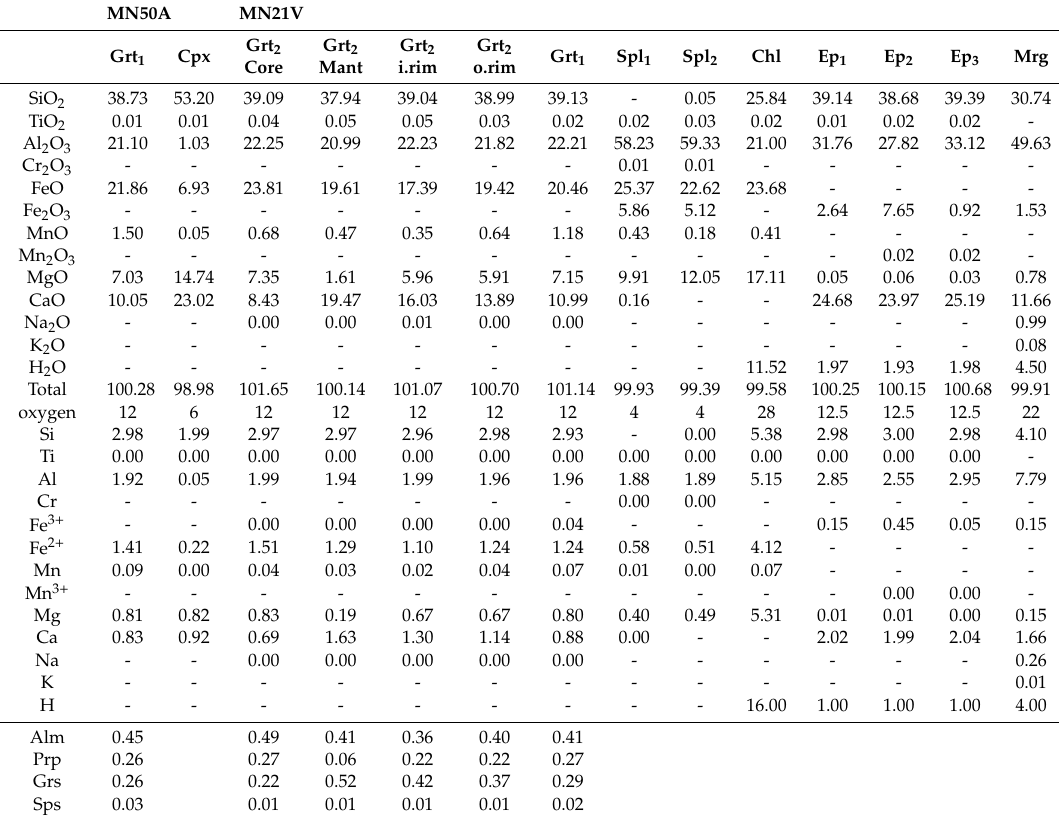
Table 1. Selected microprobe analyses (wt%) of the main phases occurring in garnet-rich vein (samples MN50A and